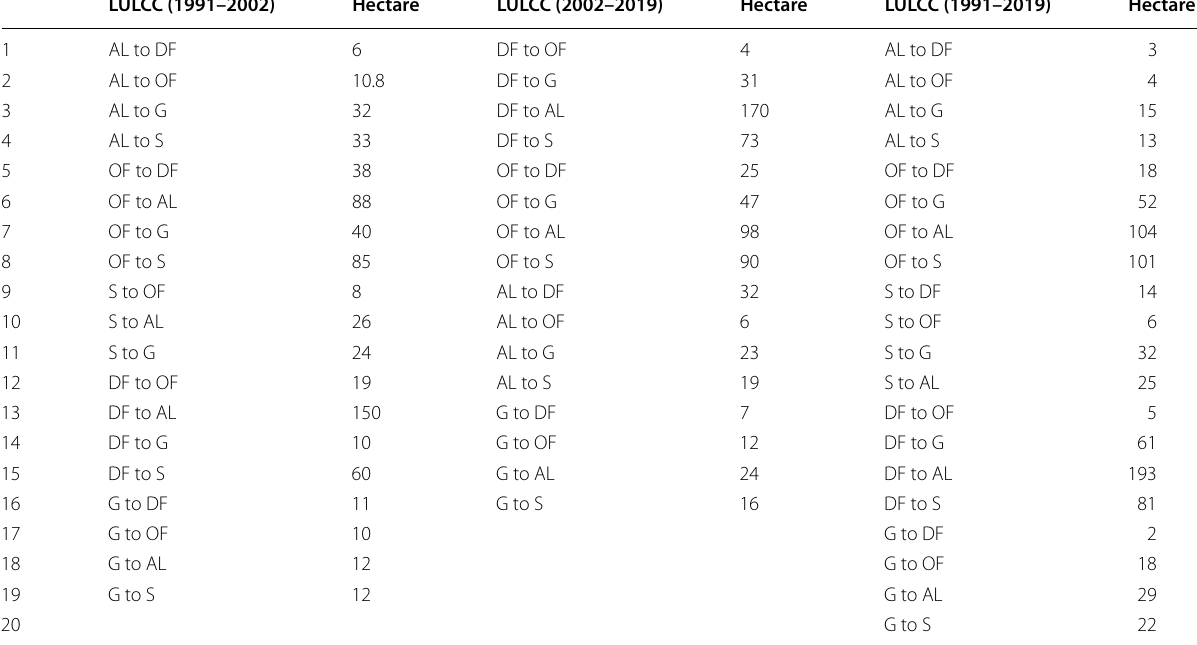
Table 7 Land cover changes detected by post classification